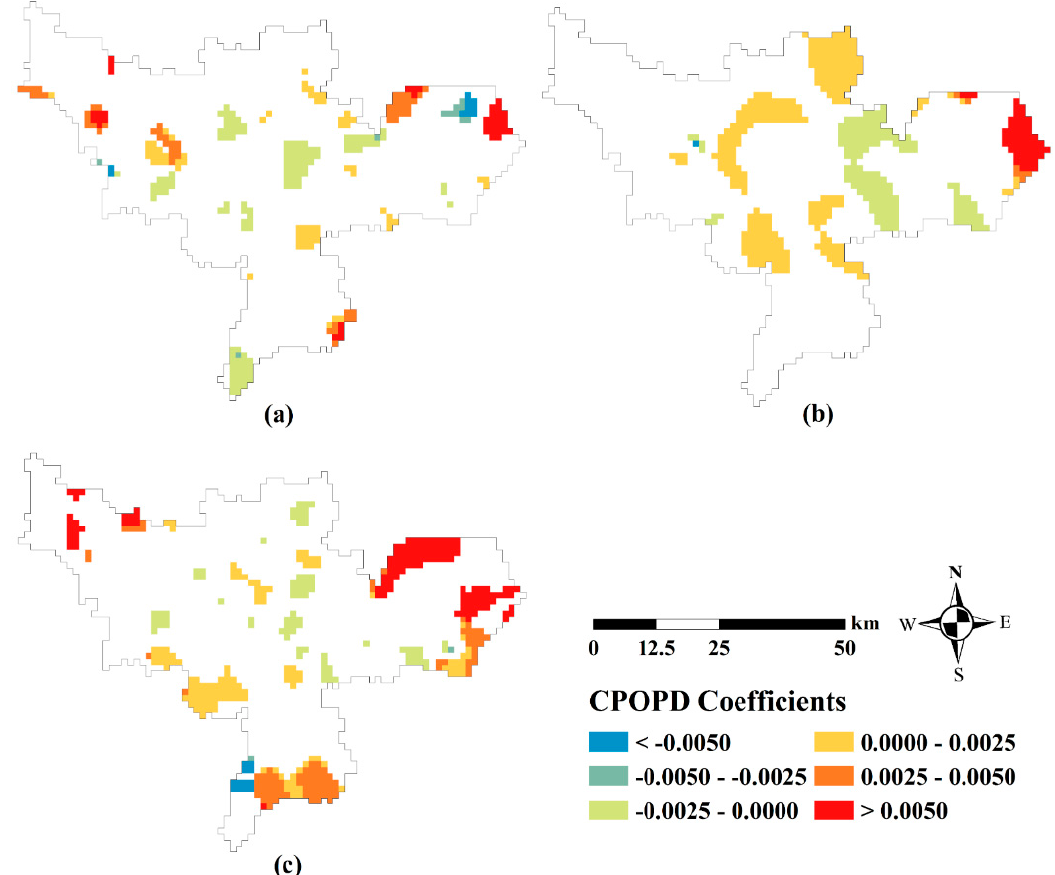
Figure 9. Spatial variations in significant local parameter estimates for the relationship between CPOPD and CSUHII: ( a ) 2000–2005; ( b ) 2005–2010; ( c ) 2010–2015. Figure 10 describes local parameter estimates for the relationship between CGSF and CSUHII. The mean CGSF coe ffi cients during the 16 years decrease from − 1.6178 in stage one (i.e., 2000–2005) to –11.7569 in stage three (i.e., 2010–2015), indicating that an increase in green space can have a significant mitigating e ff ect on the SUHII at di ff erent stages of the urbanization process in the HMA. The majority of the local estimates are statistically significant negative during the three stages, however the local relationships between CGSF and CSUHII also showed a statistically significant positive in some exurban and suburban areas, coinciding with the urban expansion and the cultivated land loss within the identical region of same